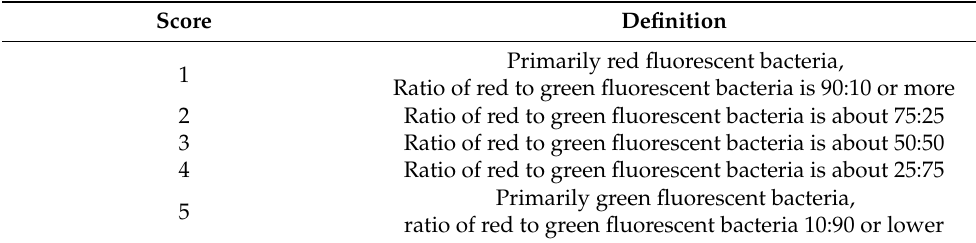
Table 2. Scoring for biofilm viability according to Nobre et al.